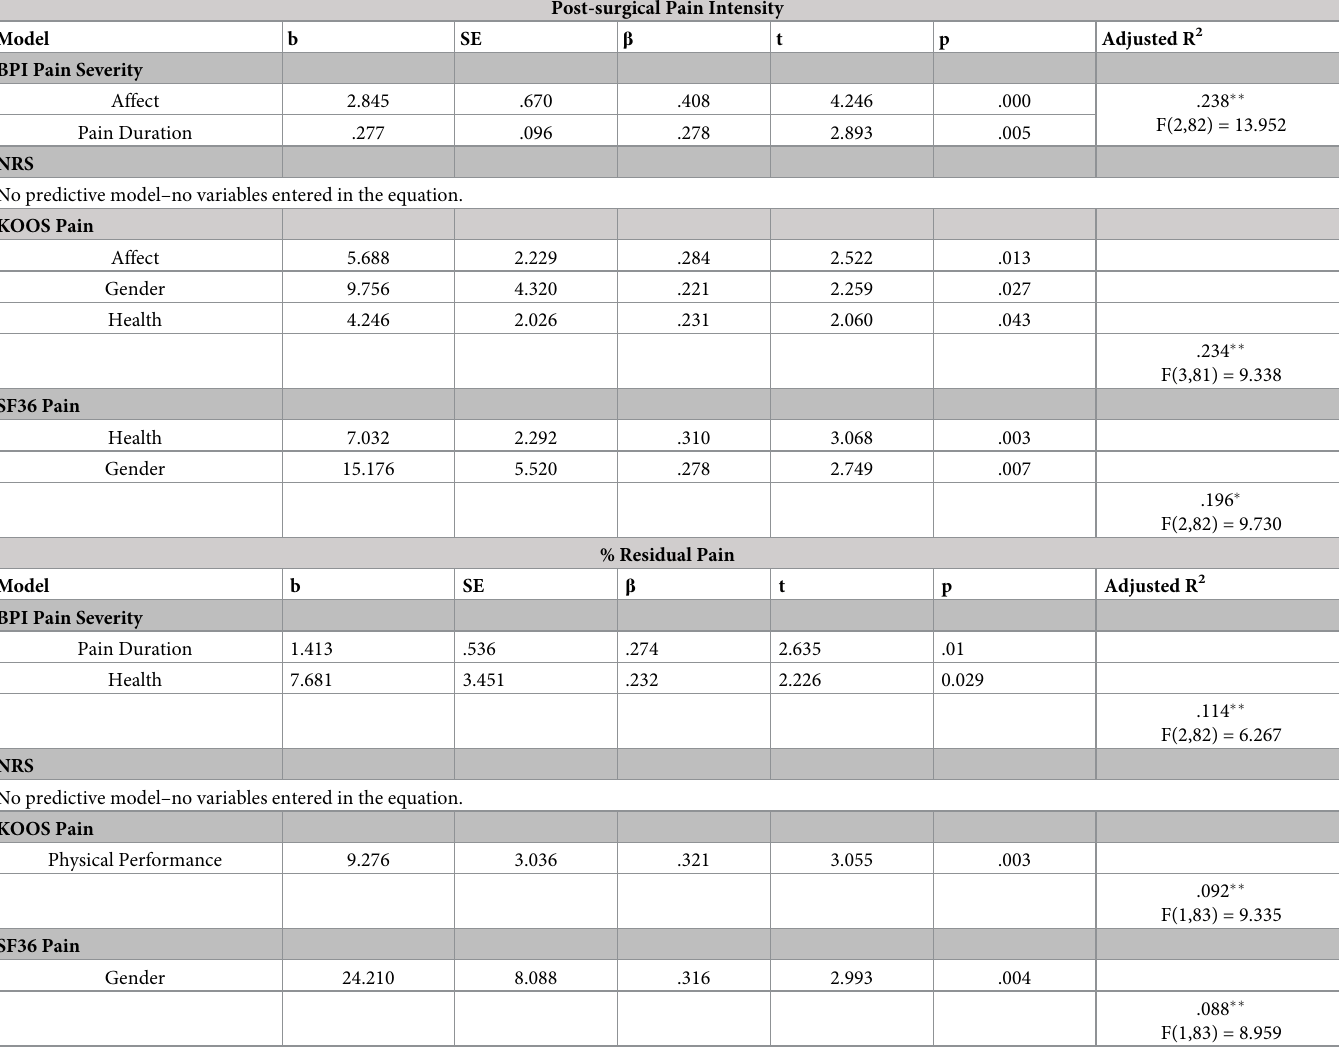
Table 4. Multiple regression models for post-surgical KOA pain intensity, and for percentage residual pain at 6-months post-surgery, for four different pain inten- sity measures. Post-surgical Pain